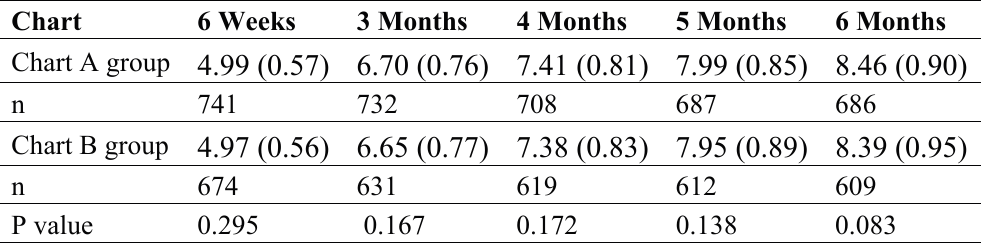
Table 2. Comparison of the weight-for-age of two groups (Mean, SD).